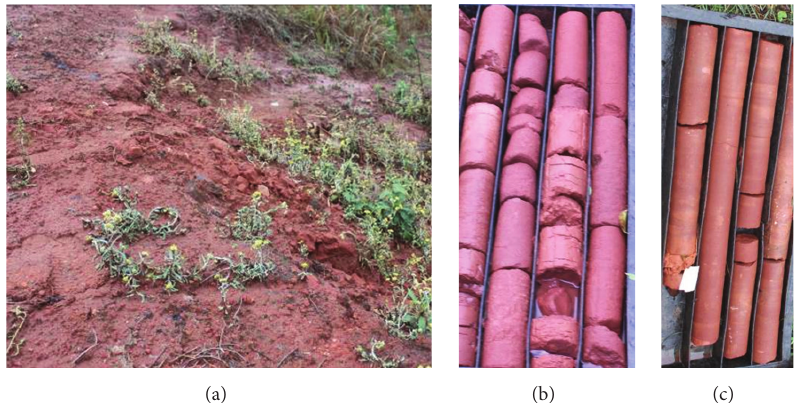
Figure 2: Site photos of the Zigong argillaceous siltstone: (a) completely weathered at the shallow surface (a type of silty clay); (b) borehole core samples of the highly weathered argillaceous siltstone and (c) borehole core samples of the moderately weathered argillaceous siltstone.